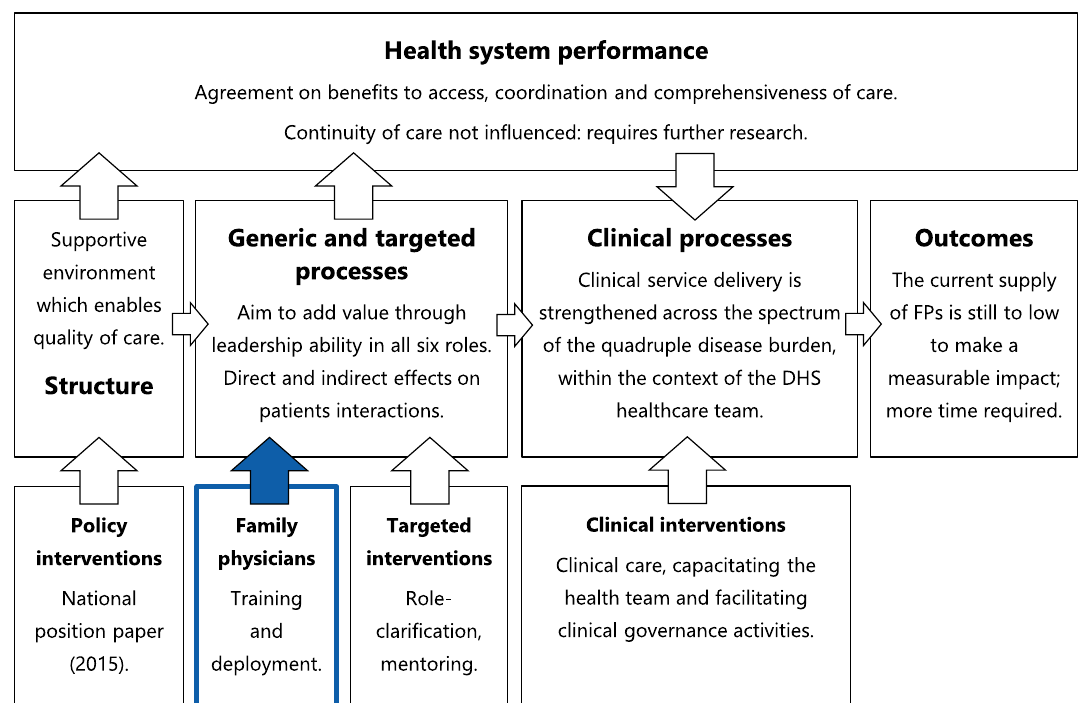
Figure 2: Visual summary of the key study